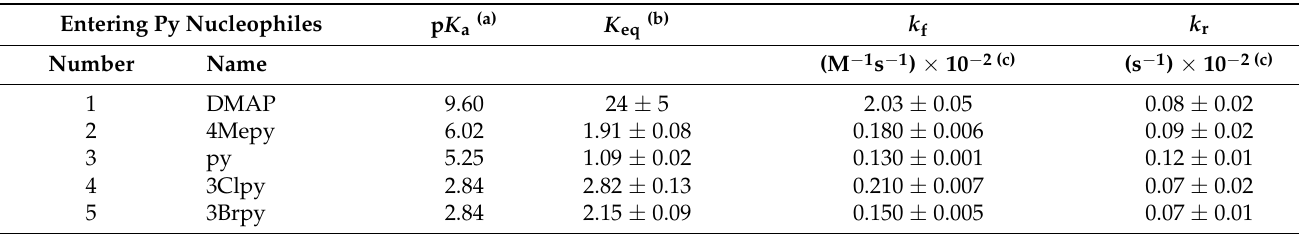
Table 5. Equilibrium, p K a , and second-order rate constants (Equations (3) and (4)) for the substitu- tion of triphenylphosphine oxide from cis -[NbO(ca) 2 (H 2 O)OPPh 3 ] − by different entering Py-type nucleophiles in acetonitrile at 31.2 ◦